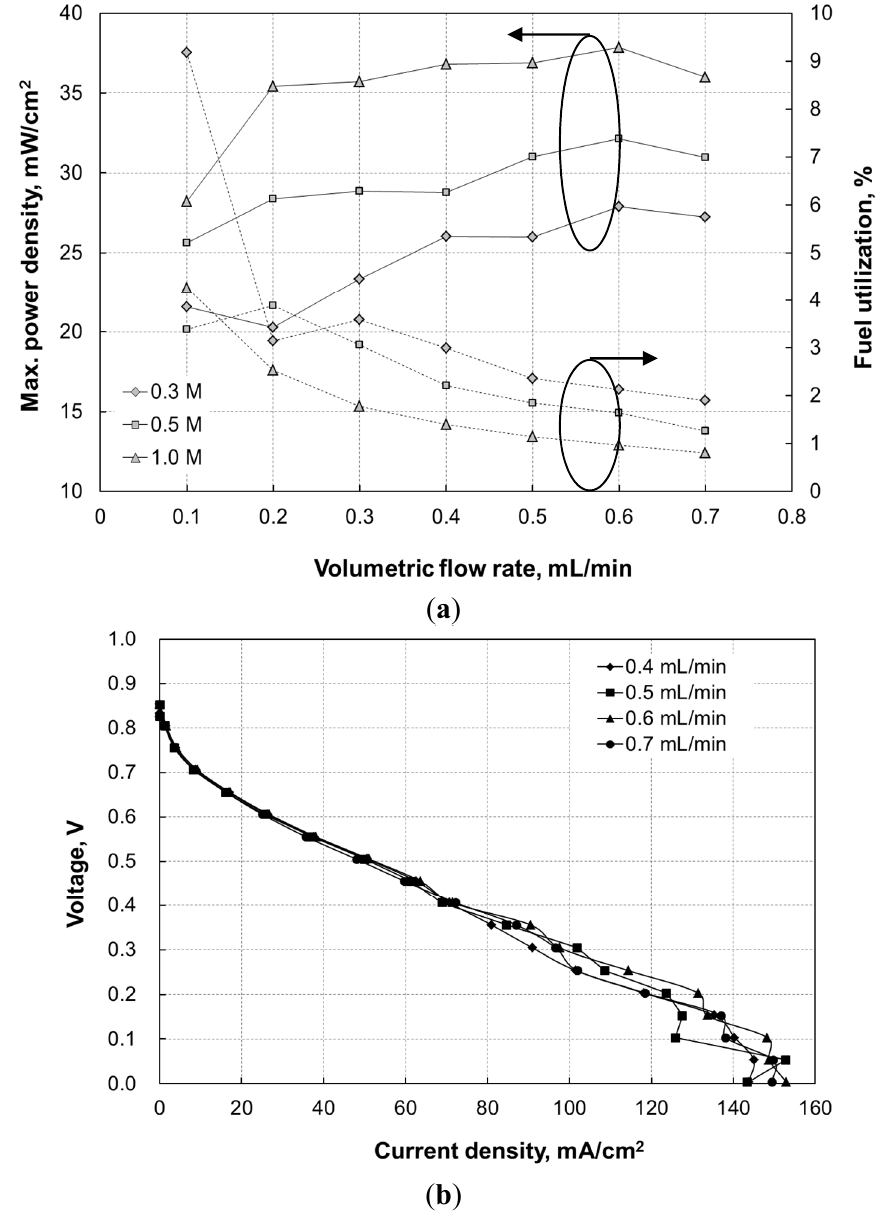
Figure 8. ( a ) Maximum power density (solid curves) and fuel utilization (dashed curves) of the microfluidic fuel cell at a formic acid concentration of 0.3 M, 0.5 M, and 1.0 M at various volumetric flow rates; and ( b ) the V - I curves of microfluidic fuel cell operated at [HCOOH] = 0.5 M and at a flow rate ranging from 0.4 mL/min to 0.7